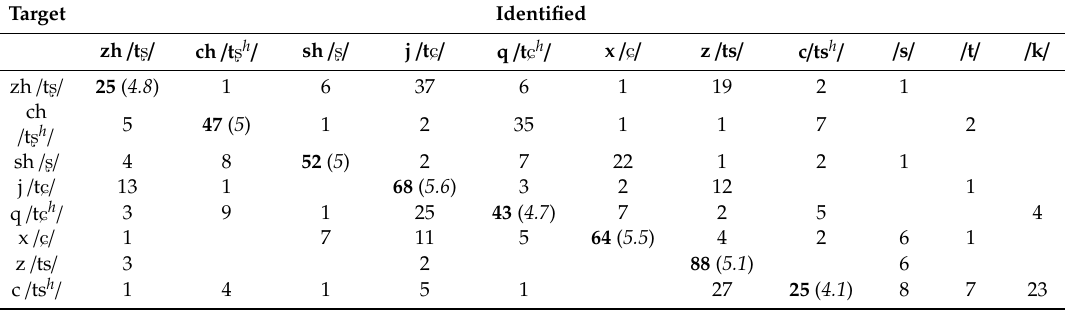
Table4. Meanpercentagecorrectproductionscores(inbold), meanratingscores(initalic), andconfusion matrix of mis-produced Mandarin consonants by native English CFL learners (N =